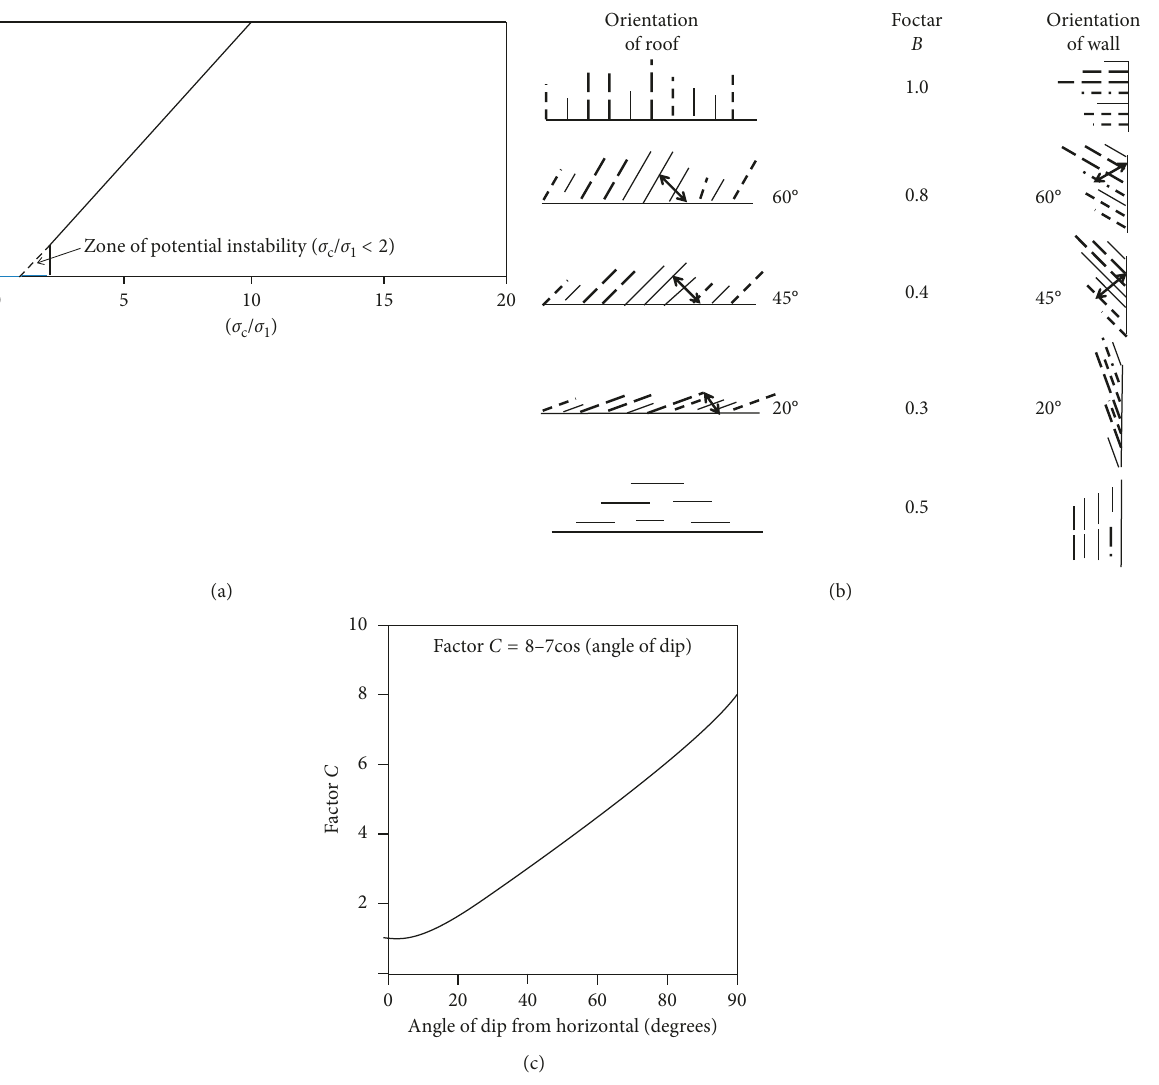
Figure 5: Adjustment factors for determining the Mathews stability number: (a) A (stress factor) (b) B (joint orientation factor), and (c) C (surface orientation factor). σ c is the uniaxial compressive strength of intact rock and σ i is the induced compressive